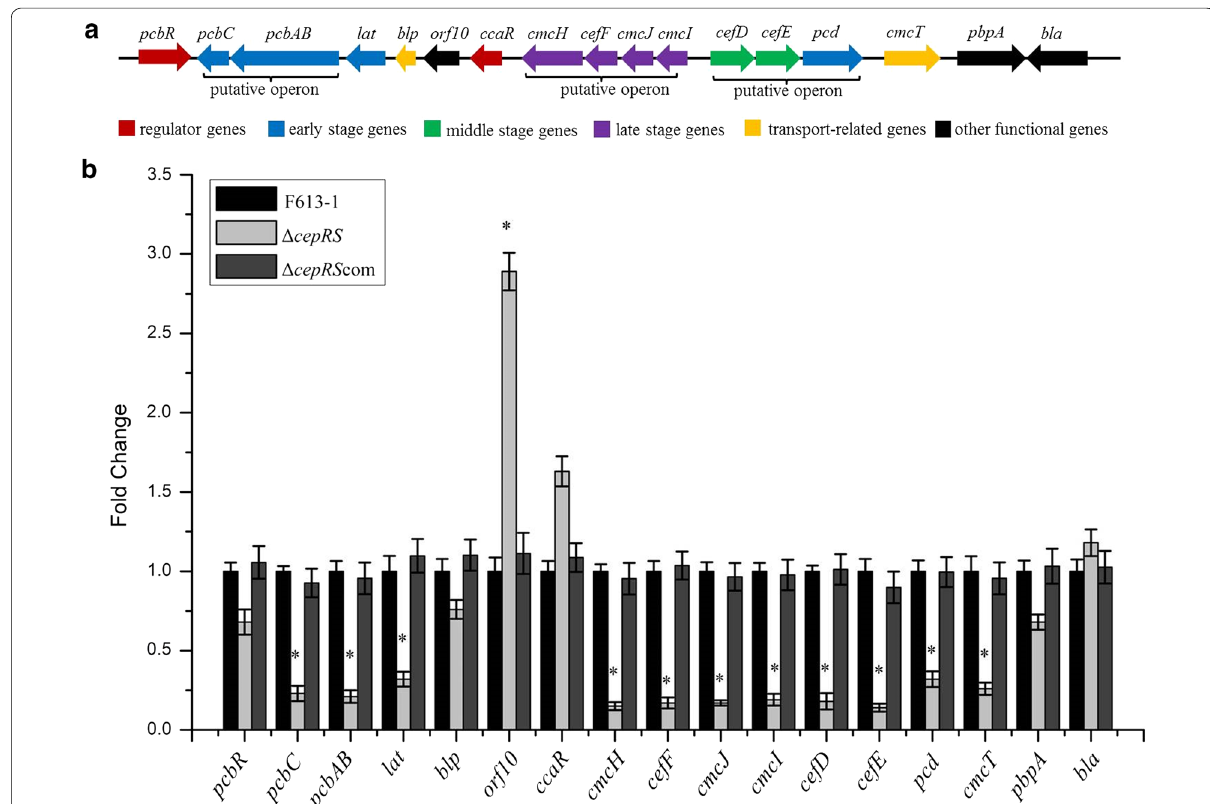
Fig. 3 Comparison of gene expression. a Schematic diagram of the cephamycin C biosynthetic gene cluster. b The expression of genes belonging to the cephamycin C biosynthetic gene cluster was examined by real-time quantitative PCR analysis using RNA extracted from Streptomyces clavuligerus strains F613-1, Δ cepRS and Δ cepRS com. Results were normalized against the expression of the 16S rRNA gene and are shown as fold change over the F613-1 control. Data are the mean standard deviation of three independent biological experiments. *Compared with F613-1, ± P <